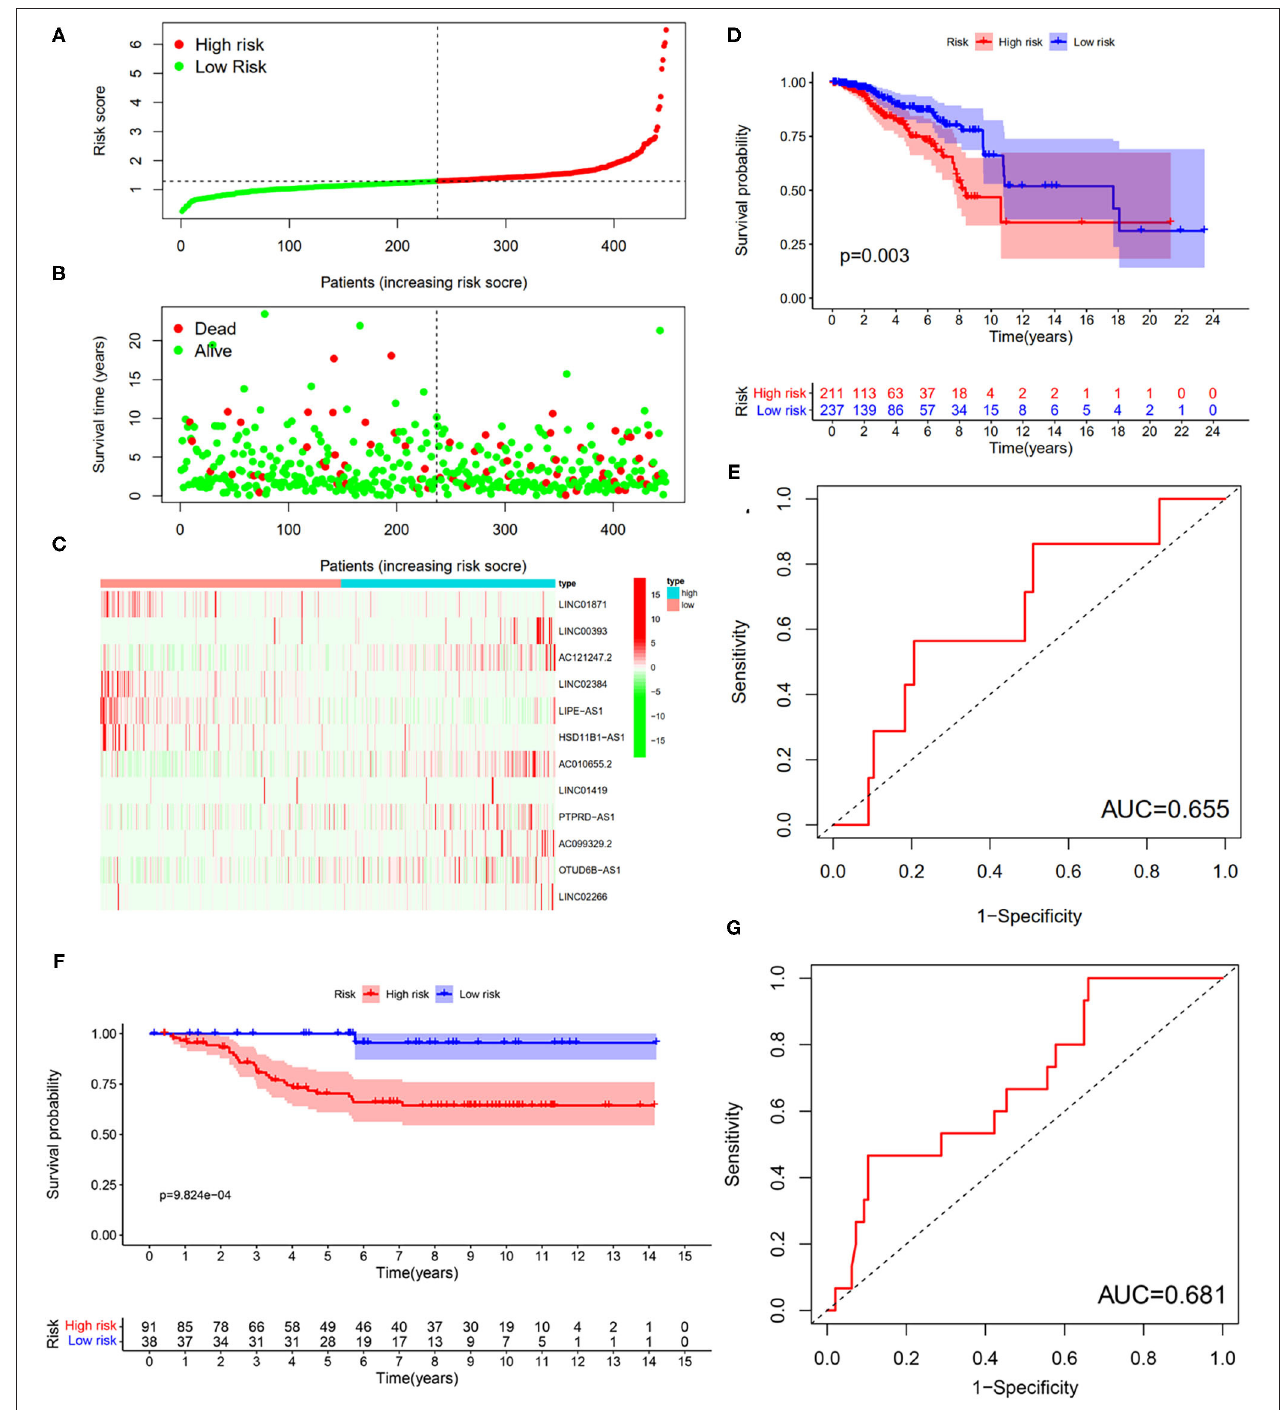
FIGURE 10 | Testing for the 12-LncRNA signature. (A) The distribution of risk score; (B) the survival time and status of patients; (C) the bottom shows the heatmap of 12-LncRNA expression profile. Colors from red to green indicate decreasing the expression level from high to low; (D) the K–M curves for high- and low-risk groups. Purple color represents the low-risk group, whereas red color represents the high-risk group; (E) ROC curves for patients with BC in the testing set. (F) The K–M curves for the high- and low-risk groups in GSE69031 cohort. Purple color represents the low-risk group, whereas red color represents the high-risk group; (G) ROC curves for patients with BC in GSE69031 cohort. AUC, area under the curve.